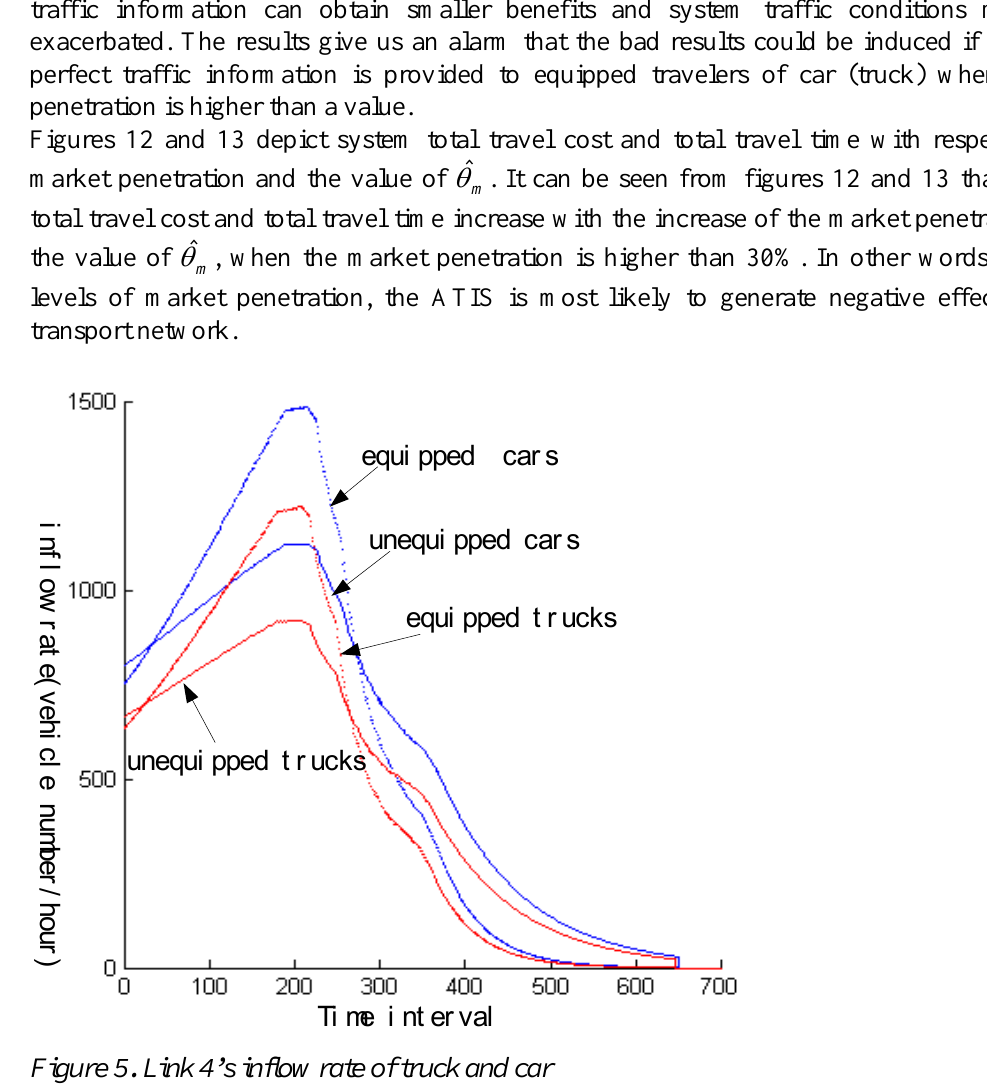
Figure 5. Link 4’s inflow rate of truck and